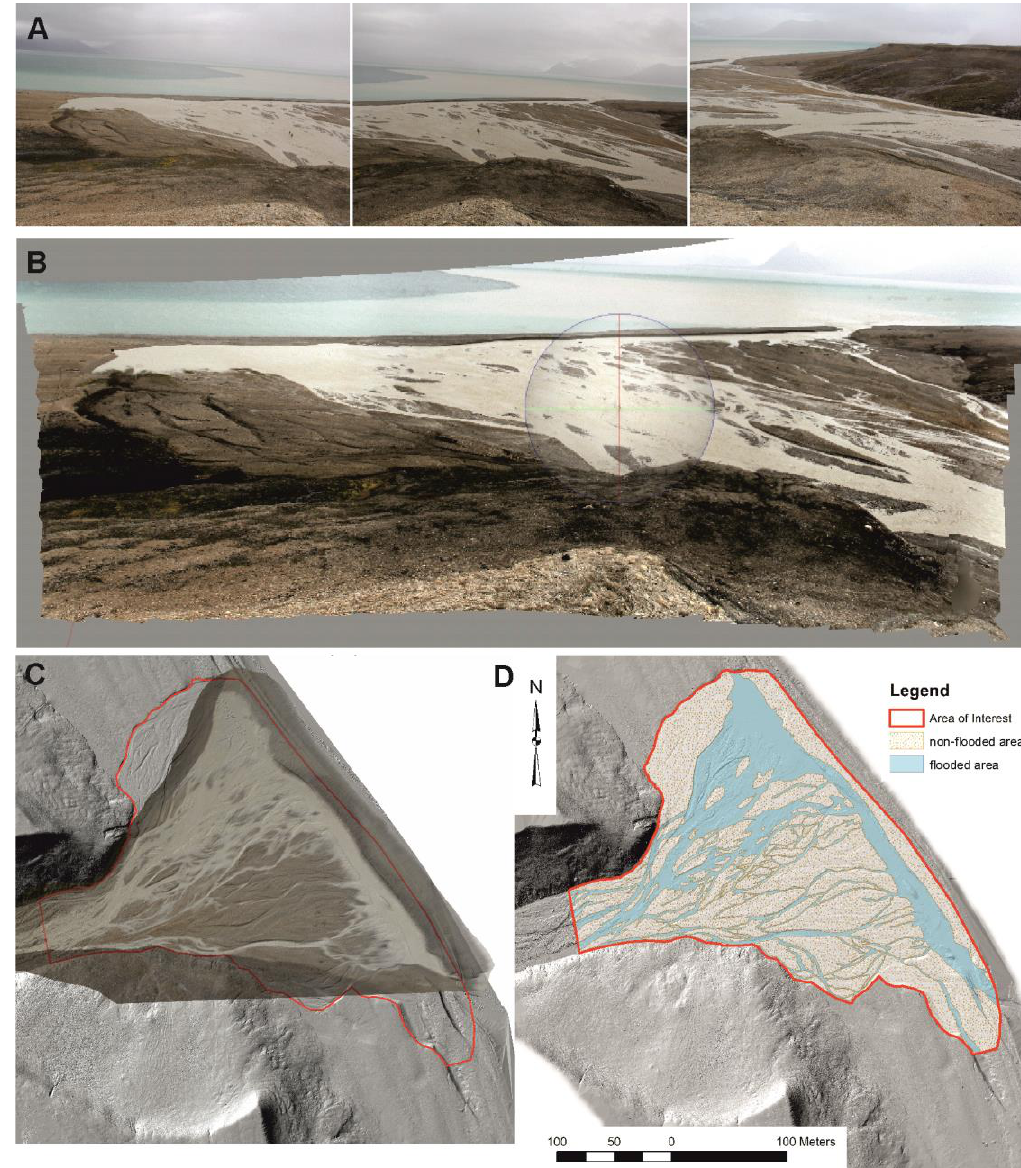
Figure 3. ( A ) Example fan images with 40% pix to pix coverage. ( B ) Images integrated in Agisoft. ( C ) Images after rectification and alignment superimposed on DTM in ArcGiS software. ( D ) Flooded and non-flooded area polygons compiled in ArcGiS.